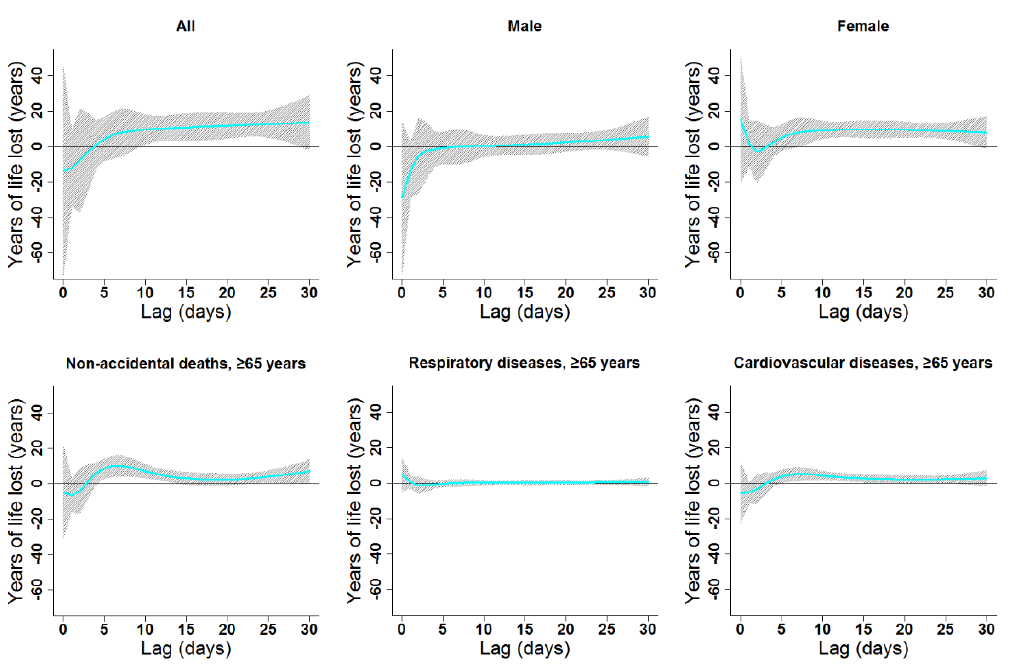
Figure 4. Lag patterns for single-day cold effects on various subgroups in Lanzhou, China. The bold lines represent the effect estimates, and the grey areas represent 95% confidence intervals. Cold effects in the present study represented changes in YLL caused by lower temperatures from the 25th to the 1st percentile of the overall temperature distribution. The reference temperature was 2.45 °C (25th percentile).